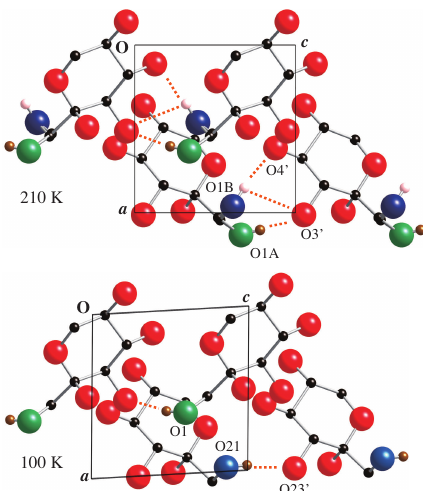
Figure 7. Diffraction photographs of crystalline D -sorbose taken at 100 K ( left ) and 210 K ( right ). The sharp spots on the extrapolation of the lines correspond to k = 2 ∼ 8 from bottom to top.